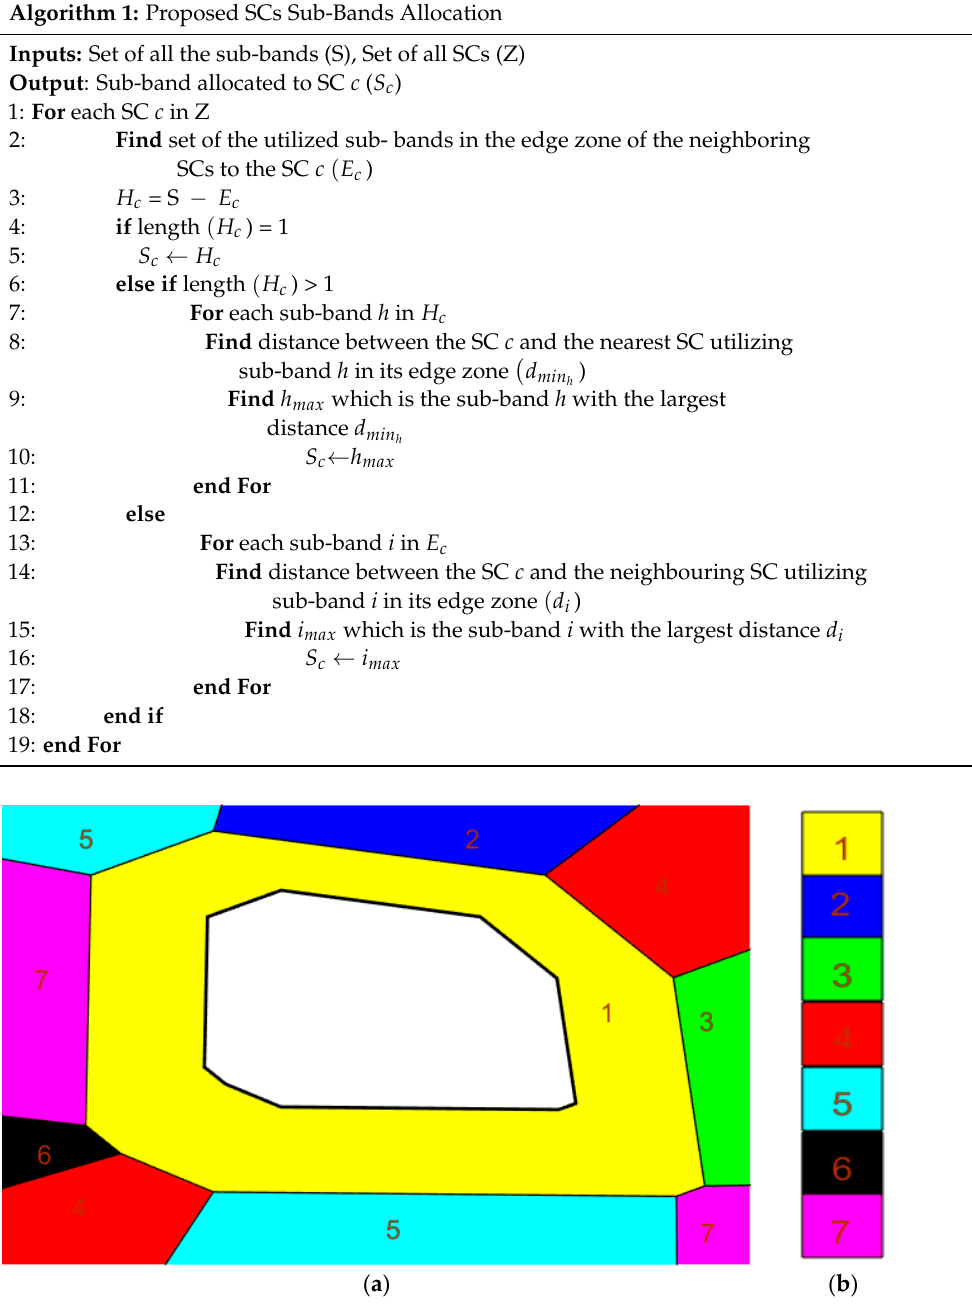
Figure 3. ( a ) A real example showing a SC (the yellow cell) with its neighboring SCs and the center zone (the white zone) is allowed to use the bands utilized by the neighbors; ( b ) the 7 utilized sub- bands.